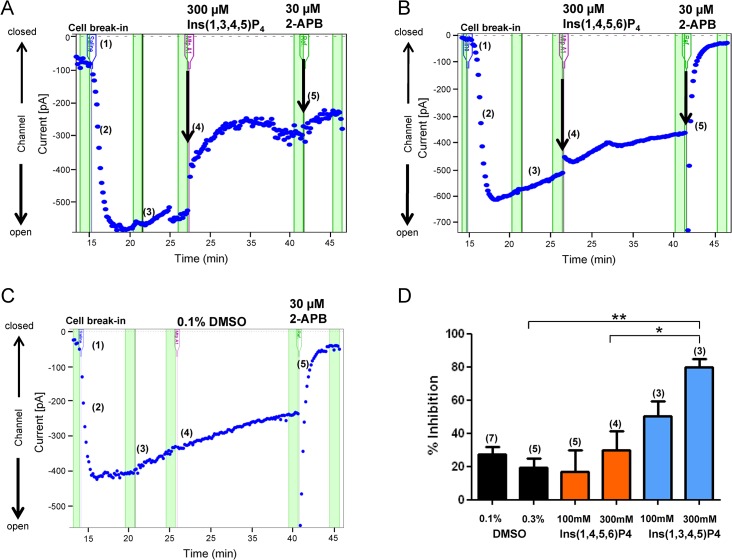
Ins(1,3,4,5)P4 inhibits Orai1-mediated current.HEK293-Orai1-Stim1 cells in serum-free media were placed on the QPatch HT recording system. Following cell break-in (1), little current was measured. Orai1 currents were then activated in a time-dependent manner following passive store depletion with an EGTA/BAPTA solution to chelate intracellular Ca2+ (2), and then stabilized in an open state (3). Next, (4), Ins(1,3,4,5)P4 (A), a control Ins(1,4,5,6)P4 (B), or 0.1% DMSO (C) was applied for 15 minutes. At the end of each experiment, 2-APB (5) was applied to block any remaining Orai1 current. In (C), percent inhibition values are expressed as the difference in current amplitude before compound application and following 2-APB application (% inhibition = ((base pA–compound pA) / (base pA– 2-APB pA)) X 100. The numbers in parentheses indicate the number of cells tested for each condition on 2 separate experimental days. Data shown is representative of three independent experiments. *, P < 0.05; **, P < 0.01